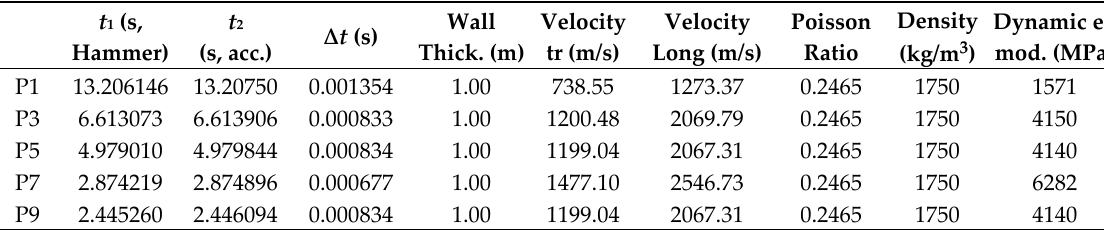
Figure 1. Jagannath Temple, Kathmandu. Table 1. Results of STs, Jagannath